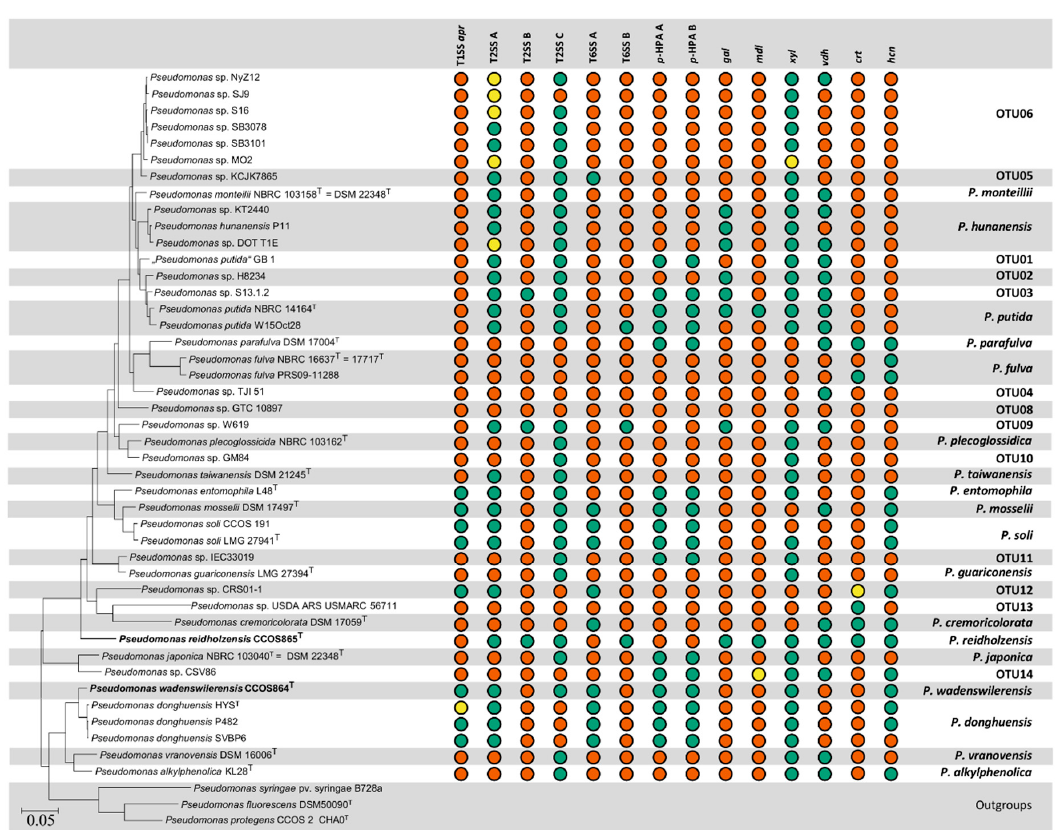
Figure 2. Core genome phylogenetic tree of the Pseudomonas putida group genomes analyzed generated using EDGAR [19] based on a total of 1 ′ 558 orthologs (573 ′ 549 amino acid residues per genome) and presence of shared features to Pseudomonas wadenswilerensis CCOS 864 T or Pseudomonas reidholzensis CCOS 865 T . Red dot: absence; green dot: presence, yellow dot: partial presence. Species taxonomy is used as given in Table 1. Abbreviations: T1SS apr : type 1 secretion system with apr genes;